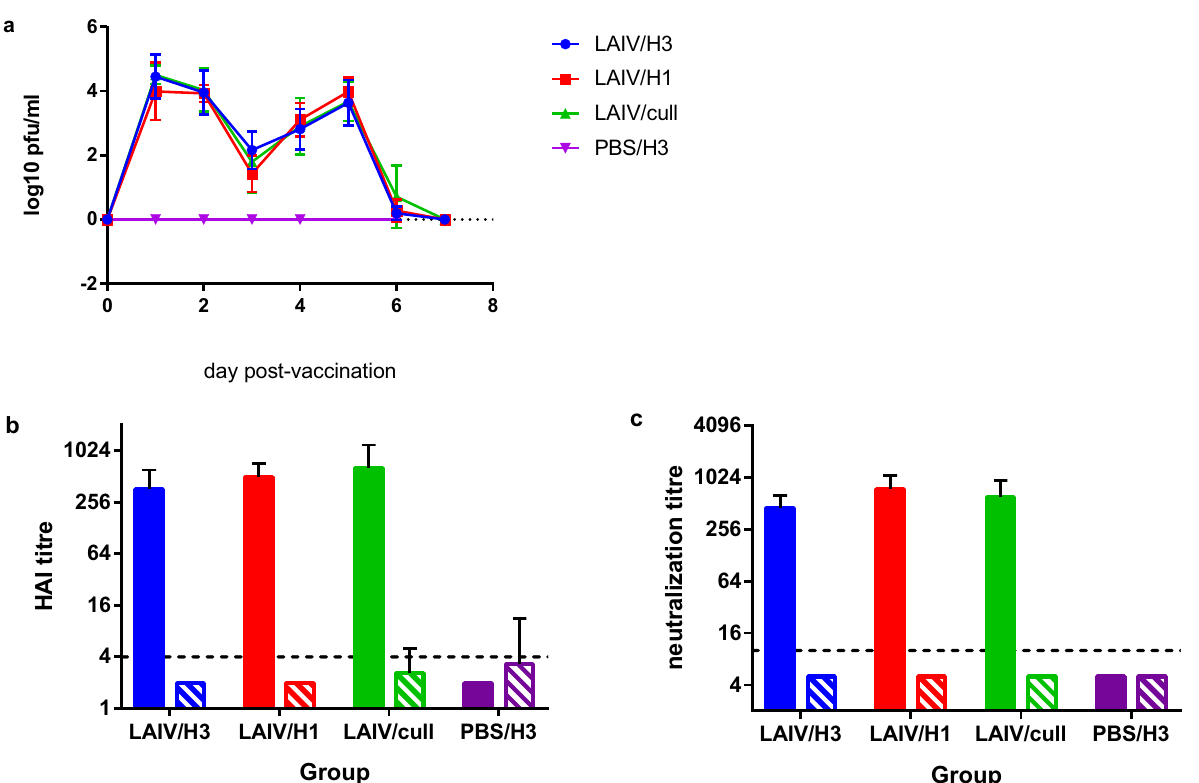
Fig. 2 Vaccination with LAIV induces virus shedding and sero-conversion. a Virus titres in nasal wash following intra-nasal vaccination with LAIV. Day -3 samples are plotted as day 0. Points show group mean and standard deviation ( n = 6). b Serum HAI titres to H1N1 and H3N2 viruses 24 days post-vaccination. c Serum microneutralization titres to H1N1 and H3N2 viruses 24 days post-vaccination. For ( b ) and ( c ), Solid bars: tested with H1N1 virus; hatched bars: tested with H3N2 virus. Dashed lines show limits of detection.